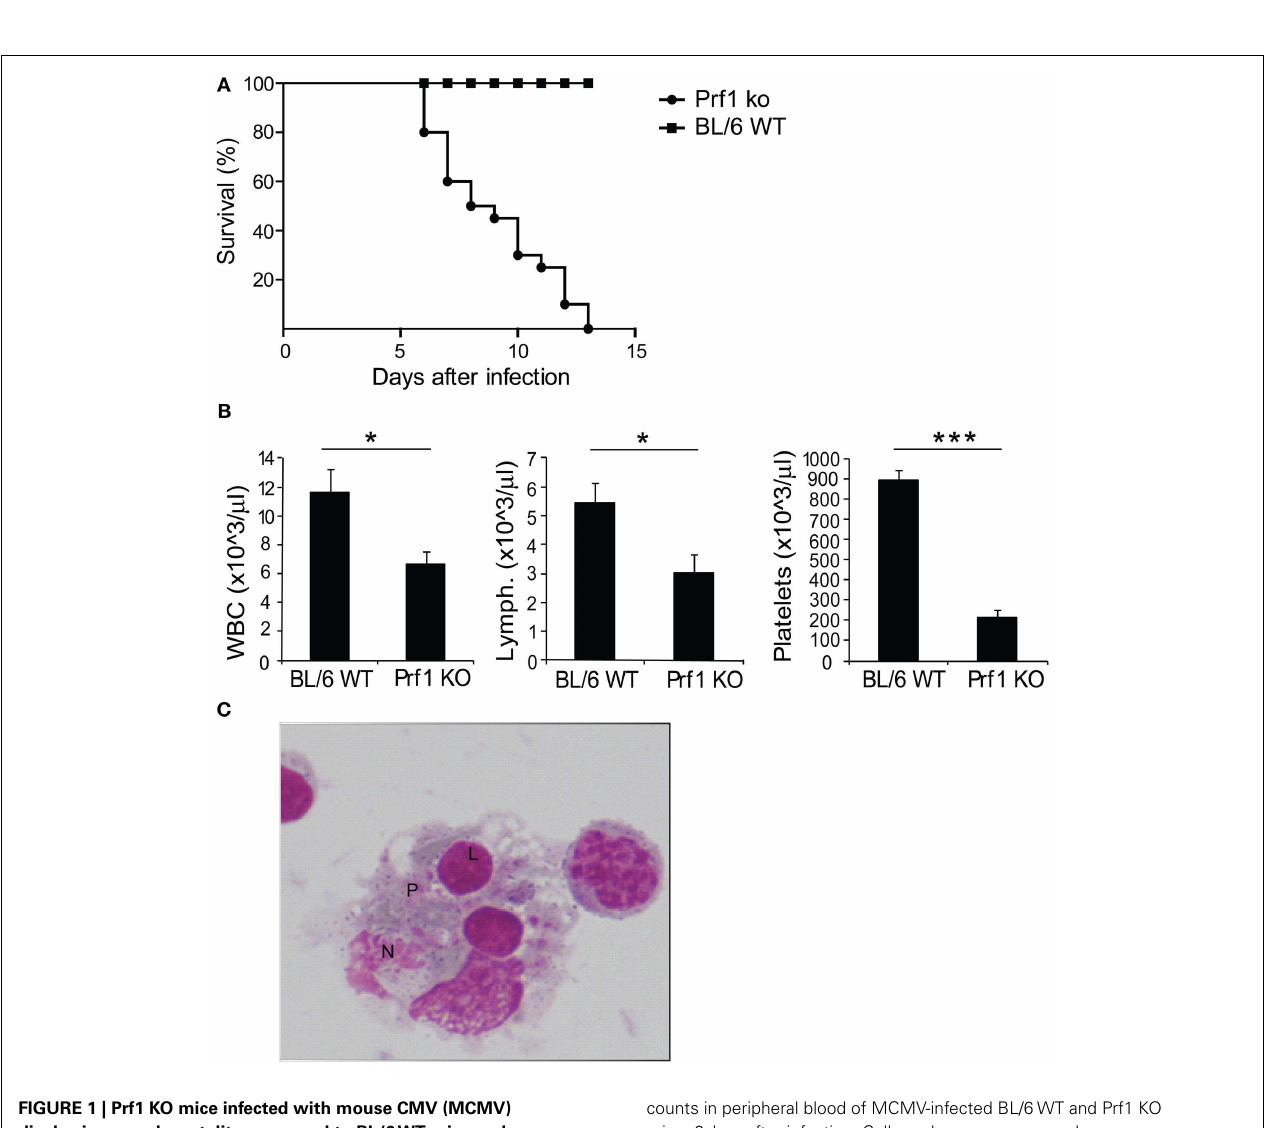
FIGURE 1 | Prf1 KO mice infected with mouse CMV (MCMV) display increased mortality compared to BL/6WT mice and develop an HLH-like phenotype. (A) Kaplan–Meier survival curves: BL/6WT mice and Prf1 KO mice were infected with 1.5 × 10 4 PFU of MCMVWT and survival was monitored for 15days after infection. N = 20 mice per group. (B) White blood cell, lymphocyte, and platelet